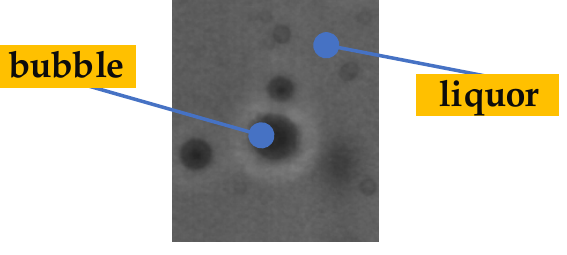
Figure 7. Air bubbles in Baijiu.